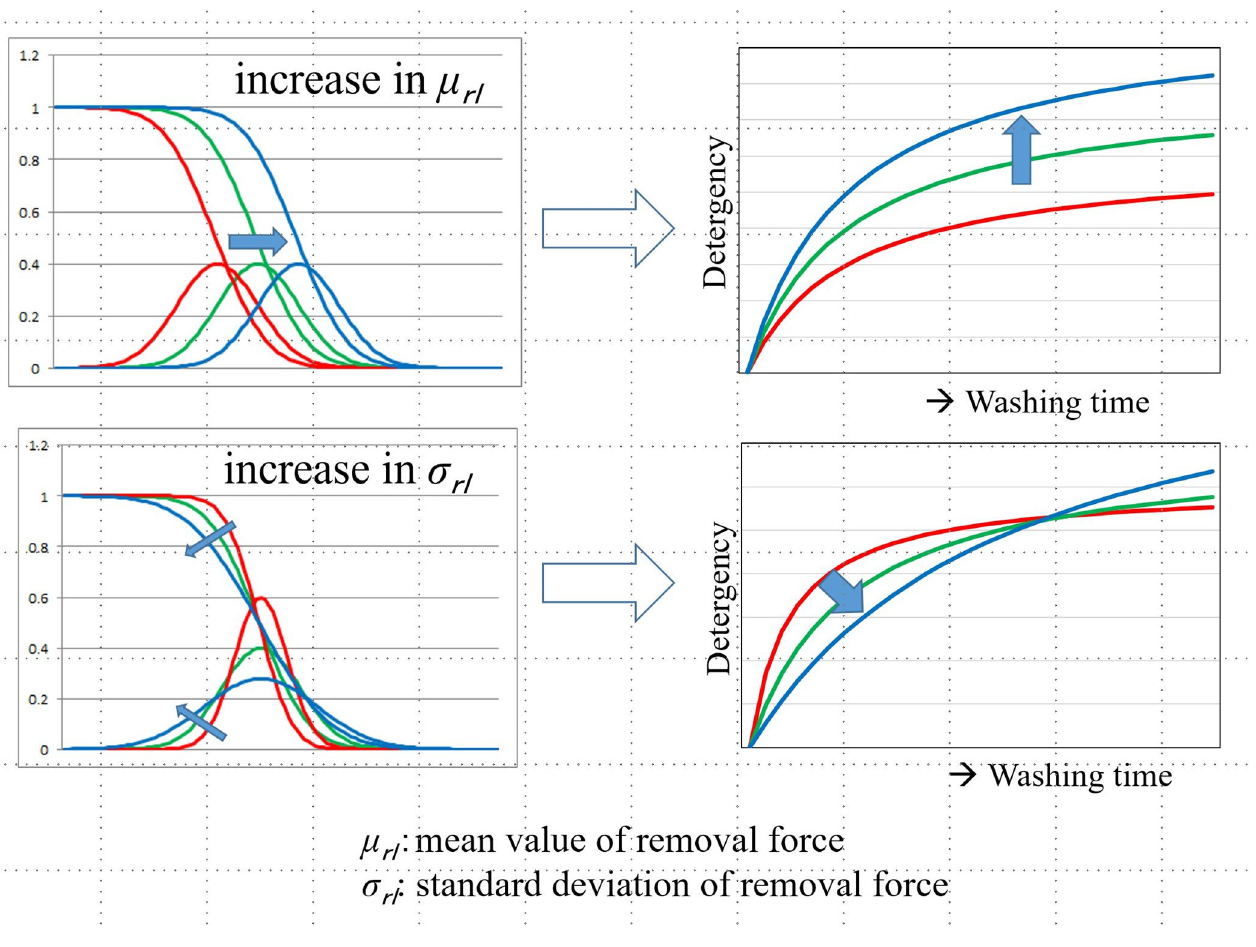
Fig 1. The meaning of two parameters μ rl and σ rl